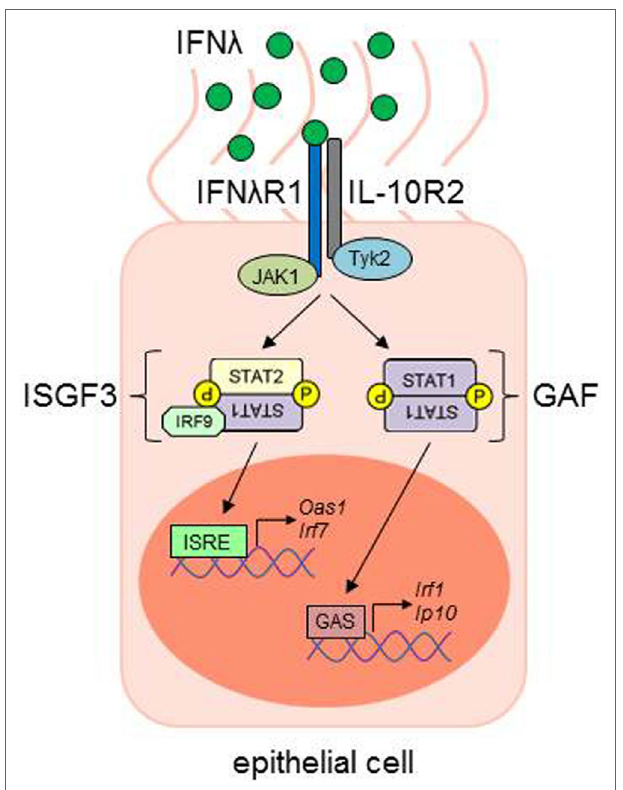
FiGURe 3 | IFN- λ signaling in CD11c + dendritic cells (DCs). CD11c + DCs express the IFN- λ receptor. Stimulation of CD11c + DCs with IFN- λ induces IL-12 production in these cells, which drives Th1 differentiation from naïve CD4 + T cells, resulting in inhibition of Th2 cell differentiation.